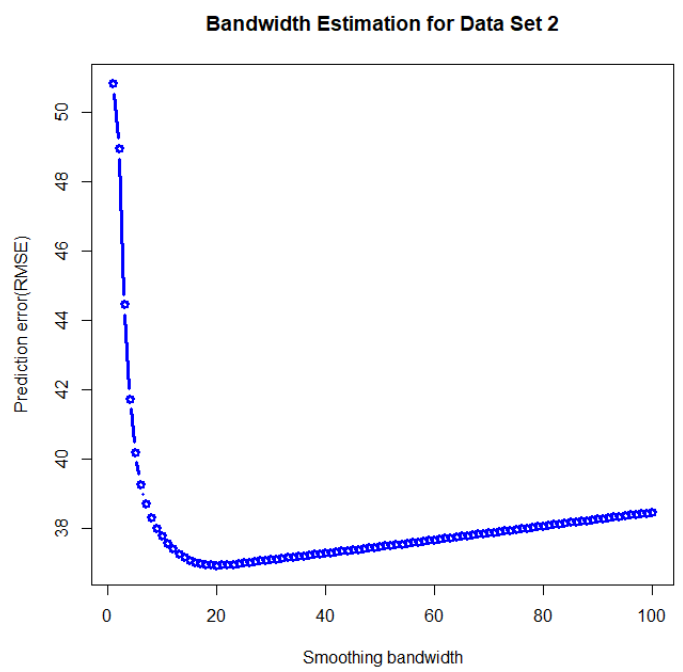
Figure 6. This is Dataset 2, collected for 8 days between 25 January 2019 and 1 February 2019. The length of the dataset is 62,878, having 74 missing datapoints in total.